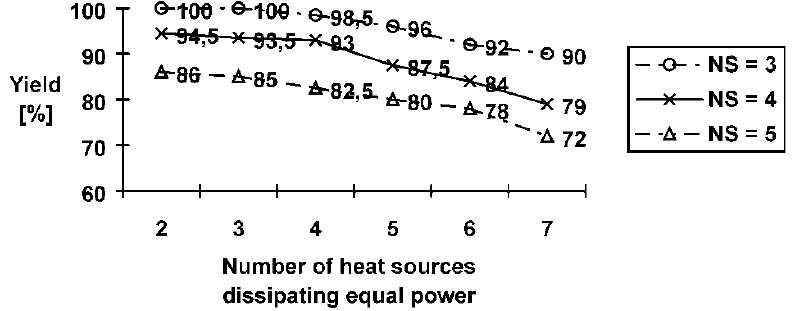
FIGURE 6 Neural algorithm yield versus the number of heat sources. NS ¼ number of subsources creating one heat source.